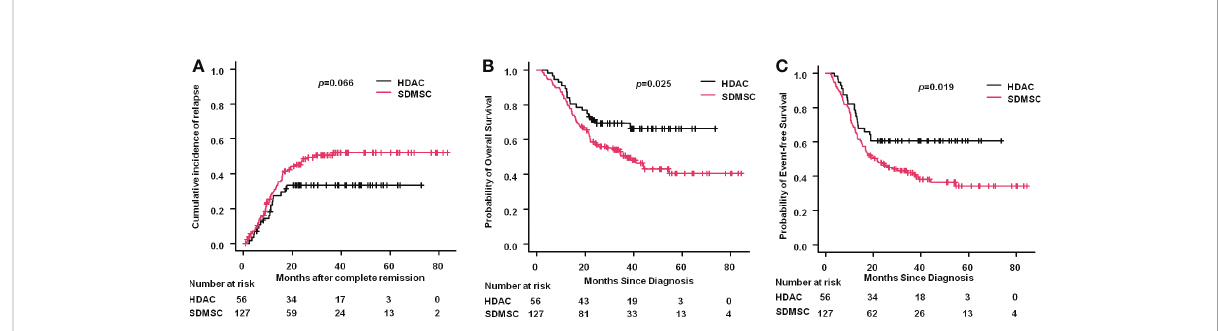
FIGURE 2 Relapse and survival in patients of aml. Cumulative incidence of relapse for the whole cohort (A) . Probability of overall survival for the whole cohort (B) . Probability of event-free survival for the whole cohort (C)